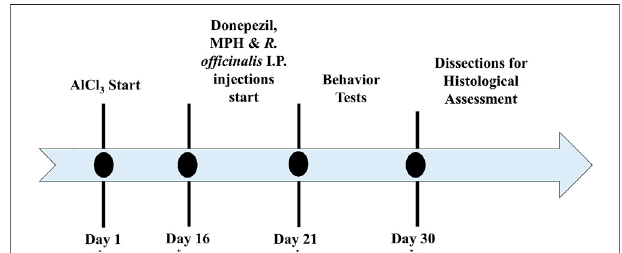
FIGURE 1 | Timeline depicting a period for the induction of Alzheimer ’ s disease (AD), treatment with Donepezil, methylphenidate (MPH), and R. of fi cinalis extract; behavior analysis; and decapitation of animals for histological